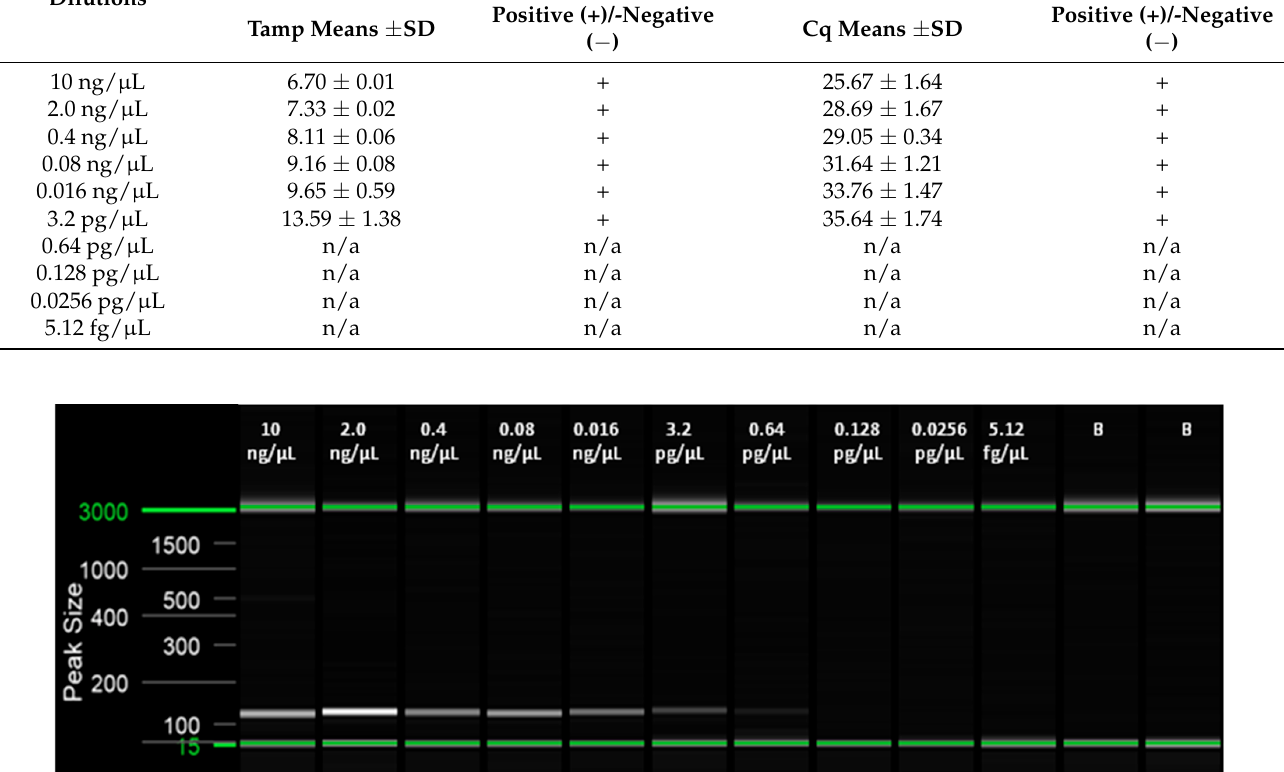
Table 4. LoD assay (comparison among different methods) based on artificial DNA from WTB frass using serial 1:5 dilutions (from 10 ng/ µ L to 2.38 fg/ µ L) and the real-time LAMP protocol. The end-point PCR (14F/125R) developed in this study was also evaluated and compared for each dilution.